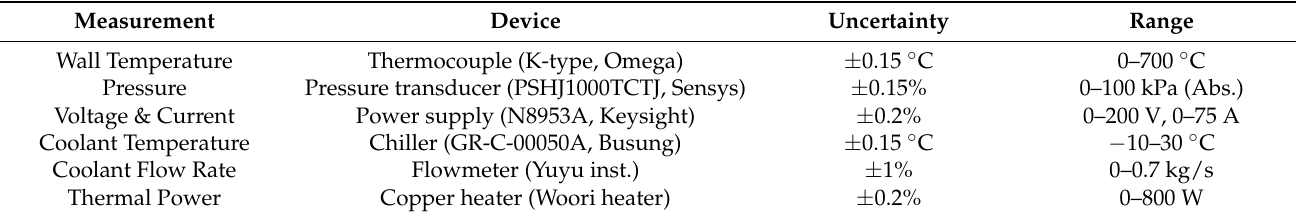
Table 2. Uncertainty of measuring device.